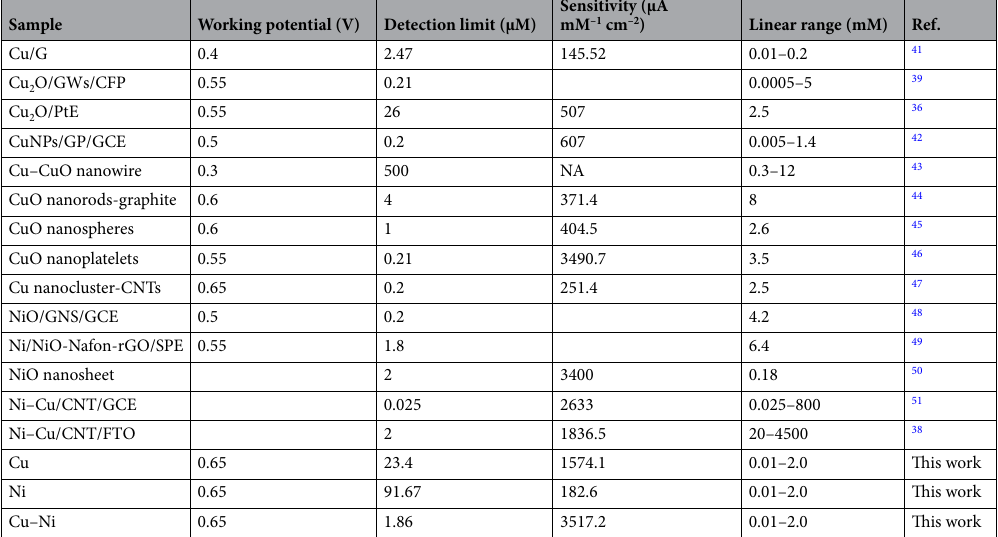
respective correlation coefficients ( R 2 ) were high, 0.9704, at a lower concentration. The amperometric measure- ments of Cu and Ni thin film electrodes are presented in Figs. S8a and S9a and respective calibration plots pre- sented in Figs. S8b and S9b. A wide linear range from 0.01 to 2.0 mM for glucose sensing behavior was observed for Cu–Ni thin film. In addition, the detection limit (LOD) of Cu–Ni thin film electrode was 1.86 μM which is 13 times lower than the Cu electrode and 50 times lower than Ni electrode and a high sensitivity 3517.2 μA mM −1 cm −2 which is 2.2 times greater than Cu and 19 times greater than Ni electrodes was achieved. This result shows that the proposed sensor has excellent sensitivity and very low detection limit. A composite material made of Ni–Cu/CNT/FTO 39 for non-enzymatic glucose sensor displayed a linear range between 0.02 and 4.5 mM, a detection limit of 2 μM, and a sensitivity of 1836.5 μA mM −1 cm −2 . Additionally, the electro-analytical perfor- mance of Cu–Ni electrode was compared with other Cu- and Ni-based catalysts tested in NaOH for glucose sensing as summarized in Table 1. Our Cu–Ni thin film electrode exhibit competitive performance with high